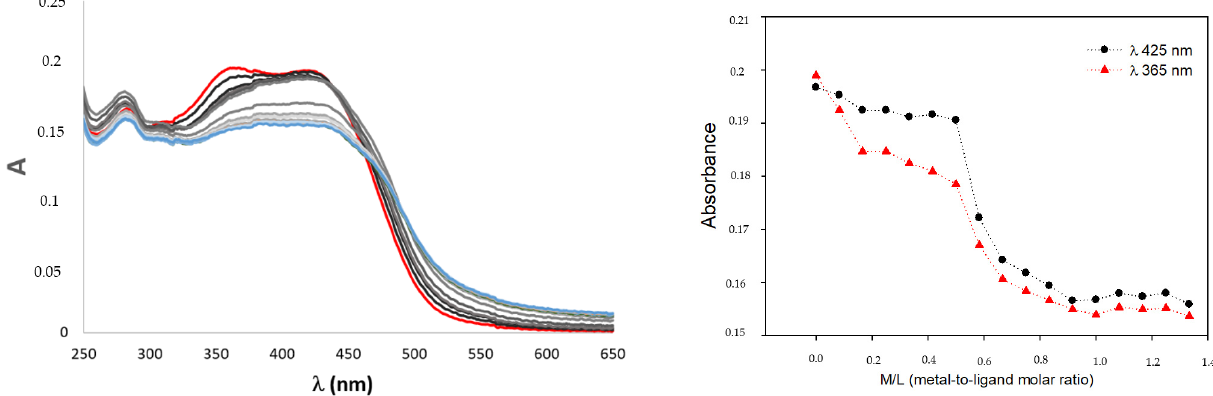
Figure 9. Spectrophotometric titration of 4 with a Ga 3+ solution in acidic conditions (pH ~5) up until the M/L 1:1.3 is reached ( left ) and plots of absorbance at different λ max vs. M/L ( right ) at 25 °C ([L] = 50 μ M).